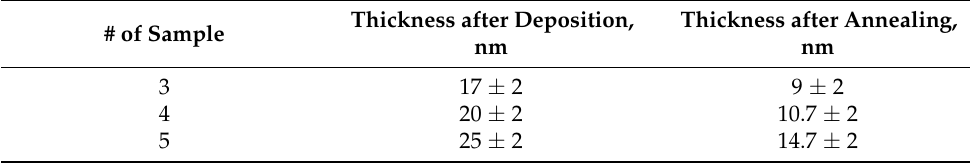
Table 2. Thicknesses of the films immediately after deposition and after annealing at 400 ◦ C in N 2 for 2 h.